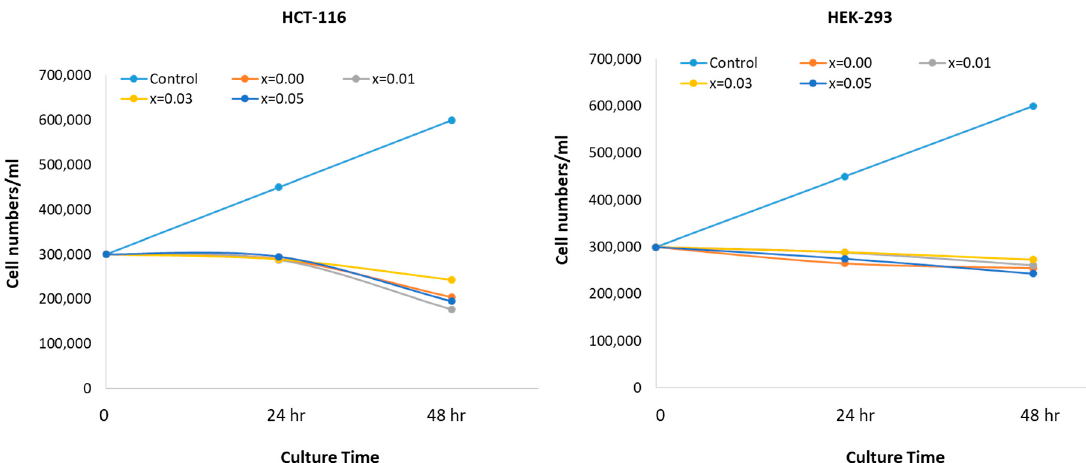
Figure 8. Cell growth curve shows the impact of treatment of Yb and Ce co-doped ZnO on the colon cancer (HCT-116) cells and normal kidney cells (HEK-293) cells post-48-h treatment.